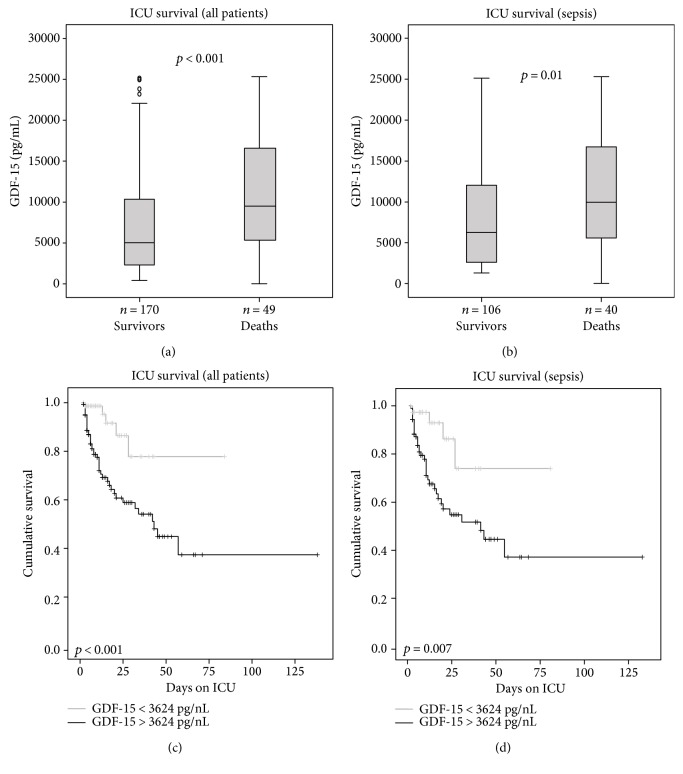
Prediction of ICU mortality by GDF-15 serum levels. (a, b) Patients that died during the course of ICU treatment ((a) all patients; (b) sepsis only) had significantly higher serum GDF-15 levels on admittance to the ICU (p < 0.001) than survivors. (c, d) Kaplan-Meier survival curves of ICU patients are displayed, showing that patients with GDF-15 below a cut-off value of 3624 pg/mL had a better outcome at the ICU ((c) all patients; (d) sepsis only).